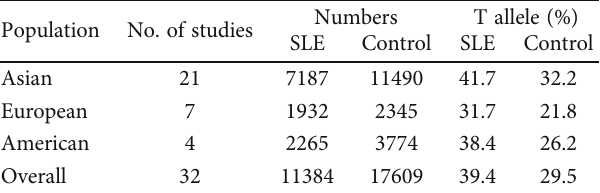
Table 2: Prevalence of T allele for STAT4 rs7574865 polymorphism in SLE patients and controls of each ethnicity.